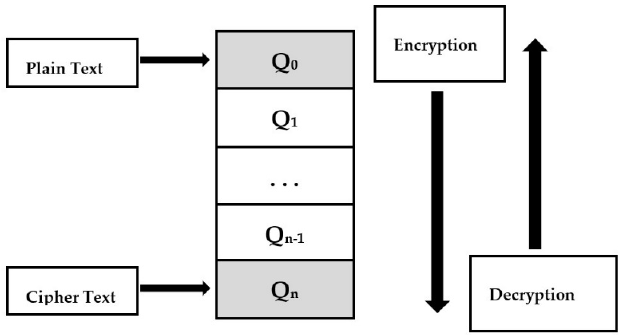
Figure 2. Forward/reverse movements.